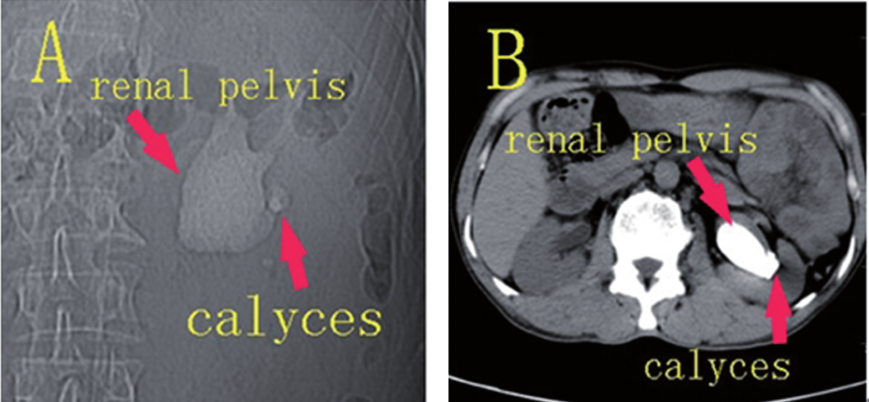
Figure 2 - Non-contrast computed tomography.